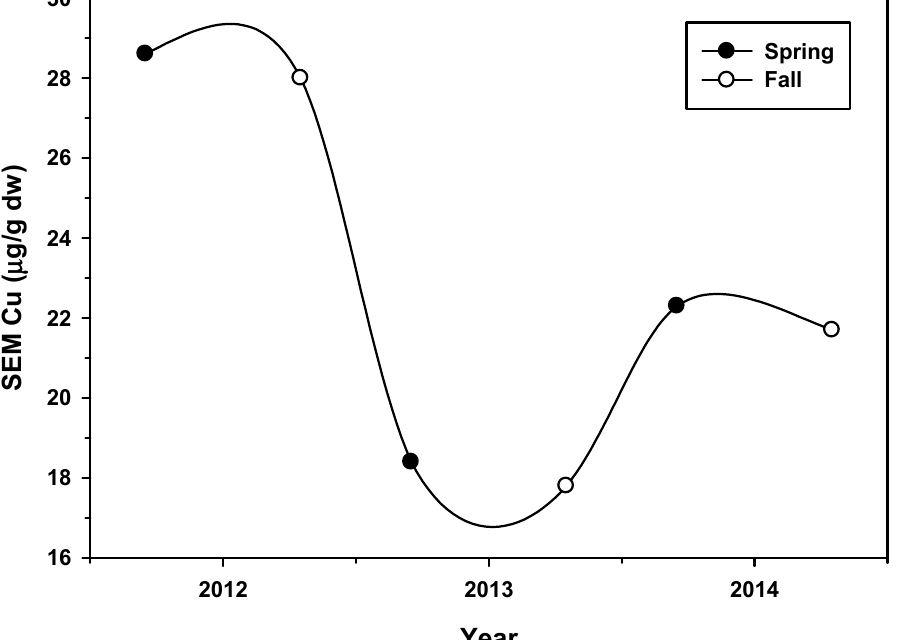
Figure 2. SEM copper concentrations (µg/g dry wt) from spring and fall sediment sampling at Cache Slough site CS-01 for the years 2012, 2013 and 2014.